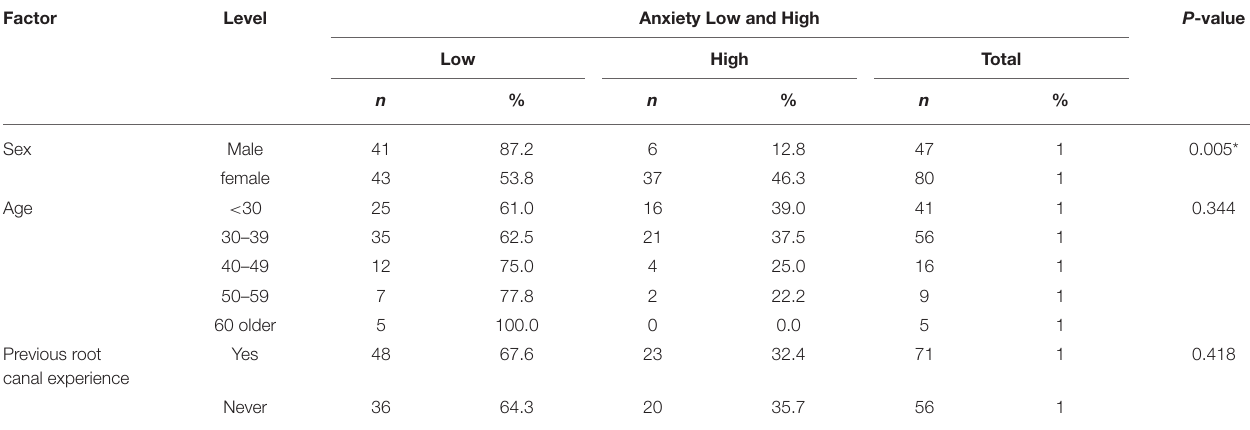
TABLE 2 | High and low anxiety scores among sex, age, and previous root canal expirence. Factor Level Anxiety Low and High P -value